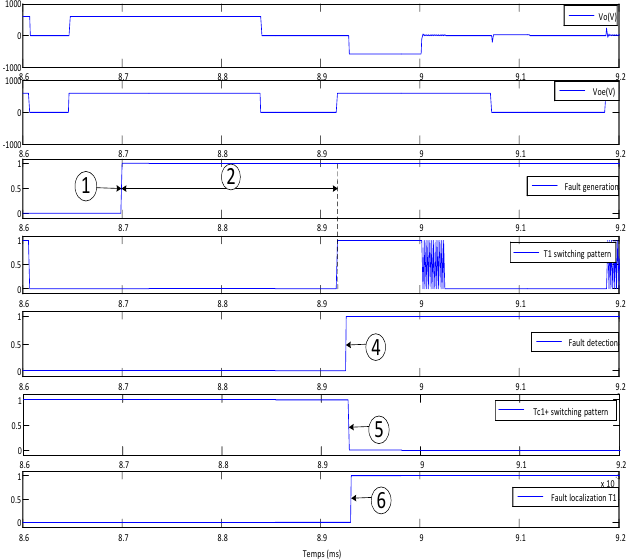
Fig.12: Zoomed Simulation results when T1 is faulty.